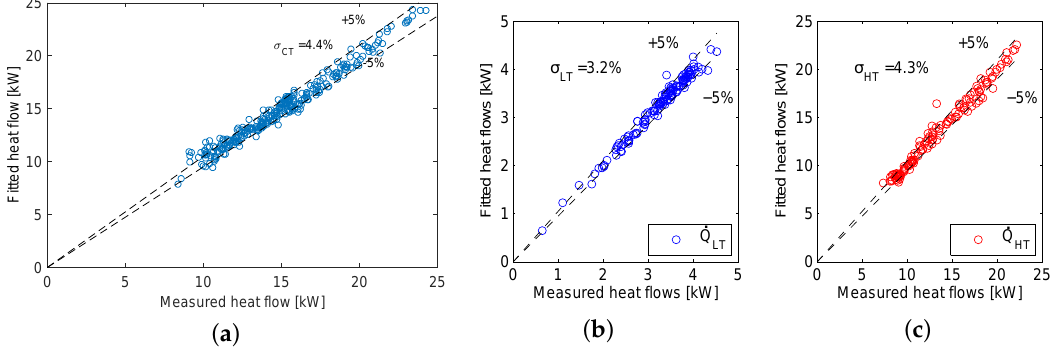
Figure B2. Fit accuracy of the characteristic equations of ( a ) the cooling tower ˙ Q MT ; ( b ) the chiller cooling capacity ˙ Q LT ; and ( c ) the chiller desorber capacity ˙ Q HT .